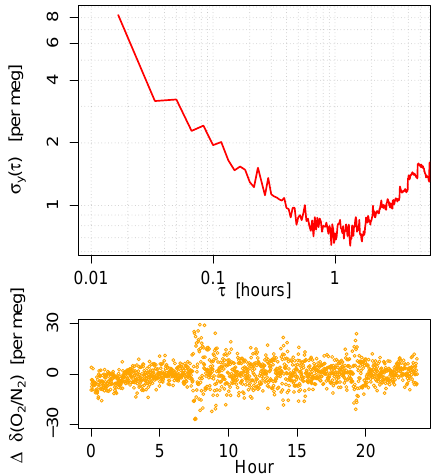
Figure 4. Log–log plot of the Allan deviation of the DFCA for the 24h of working tank flow (top panel) and anomaly of δ (O 2 / N 2 ), calculated as the instantaneous data minus the mean of the whole test (bottom